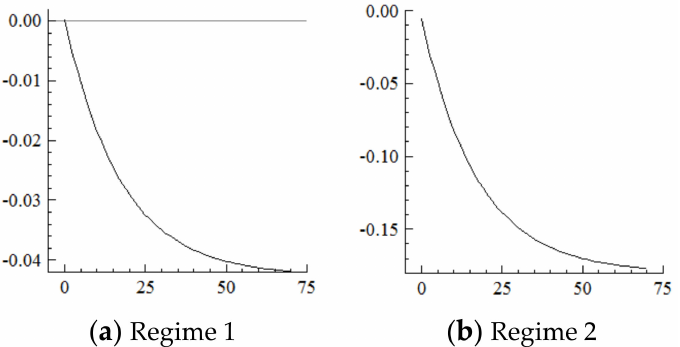
Figure 3. Cumulative Impulse Response of Labor Supply to Population Aging Shocks.